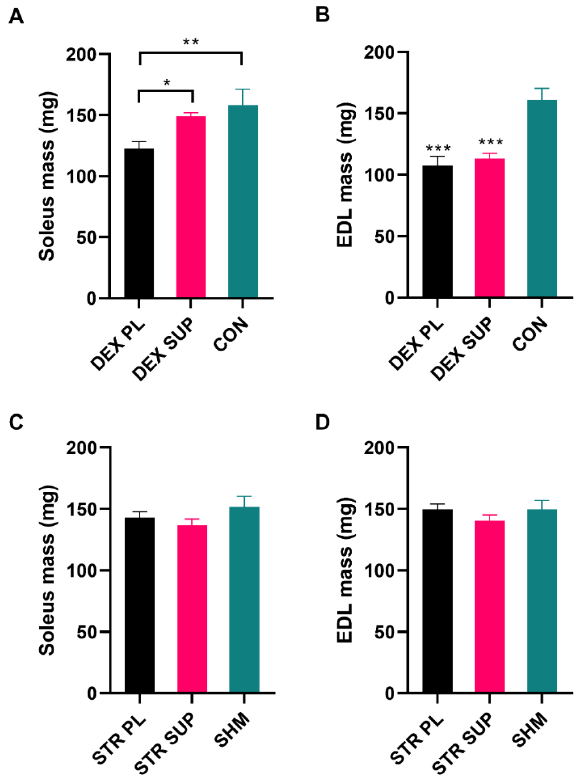
Figure 5. The SOL and EDL muscles mass at the end of the experiment in DEX-treated ( A , B ), and stressed ( C , D ) rats. Results are expressed as mean ± SEM. DEX PL ( n = 7), DEX SUP ( n = 8), CON ( n = 6), STR PL ( n = 9), STR SUP ( n = 9), SHM ( n = 6), * p < 0.05 vs. DEX SUP, ** p < 0.01, *** p < 0.001 vs. CON. DEX PL: dexamethasone-treated group supplemented with placebo; DEX SUP: dexame- thasone-treated group supplemented with vitamin D 3 ; CON: control group; STR PL: cold water immersion group supplemented with placebo; STR SUP: cold water immersion group supple- mented with vitamin D 3 ; SHM: sham cold water immersion group.